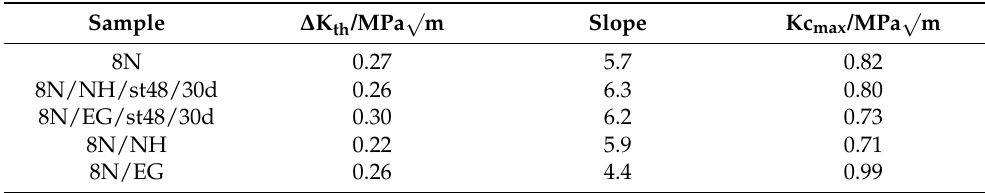
Table 2. Determined values from the FCP measurements under ESC for EG and NH via the two wetting procedures and the neat PMMA material.